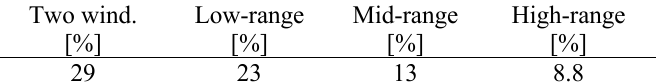
Table 8: The maximum errors of Mohan’s current sheet